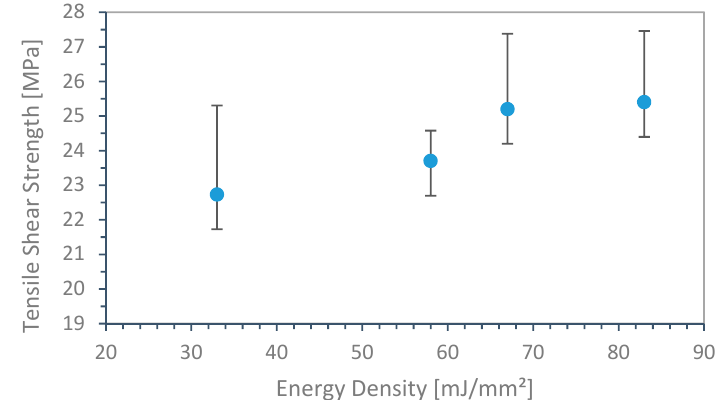
Figure 4. Tensile shear strength of hybrid produced similar material specimen (PA12 on PA12).